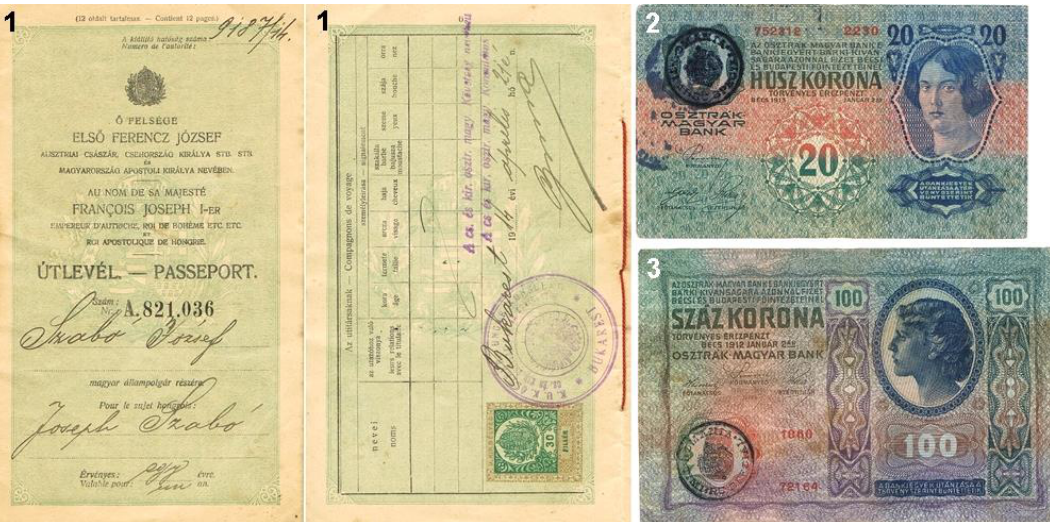
Figure 1: Historical documents hidden, preserved and discovered in old houses, in the region of Rupea, 1 – A passport from the Austro-Hungarian Empire (last used in 1914), 2 and 3 – Over-stamped Austro-Hungarian krone banknotes, used in the Kingdom of Romania after